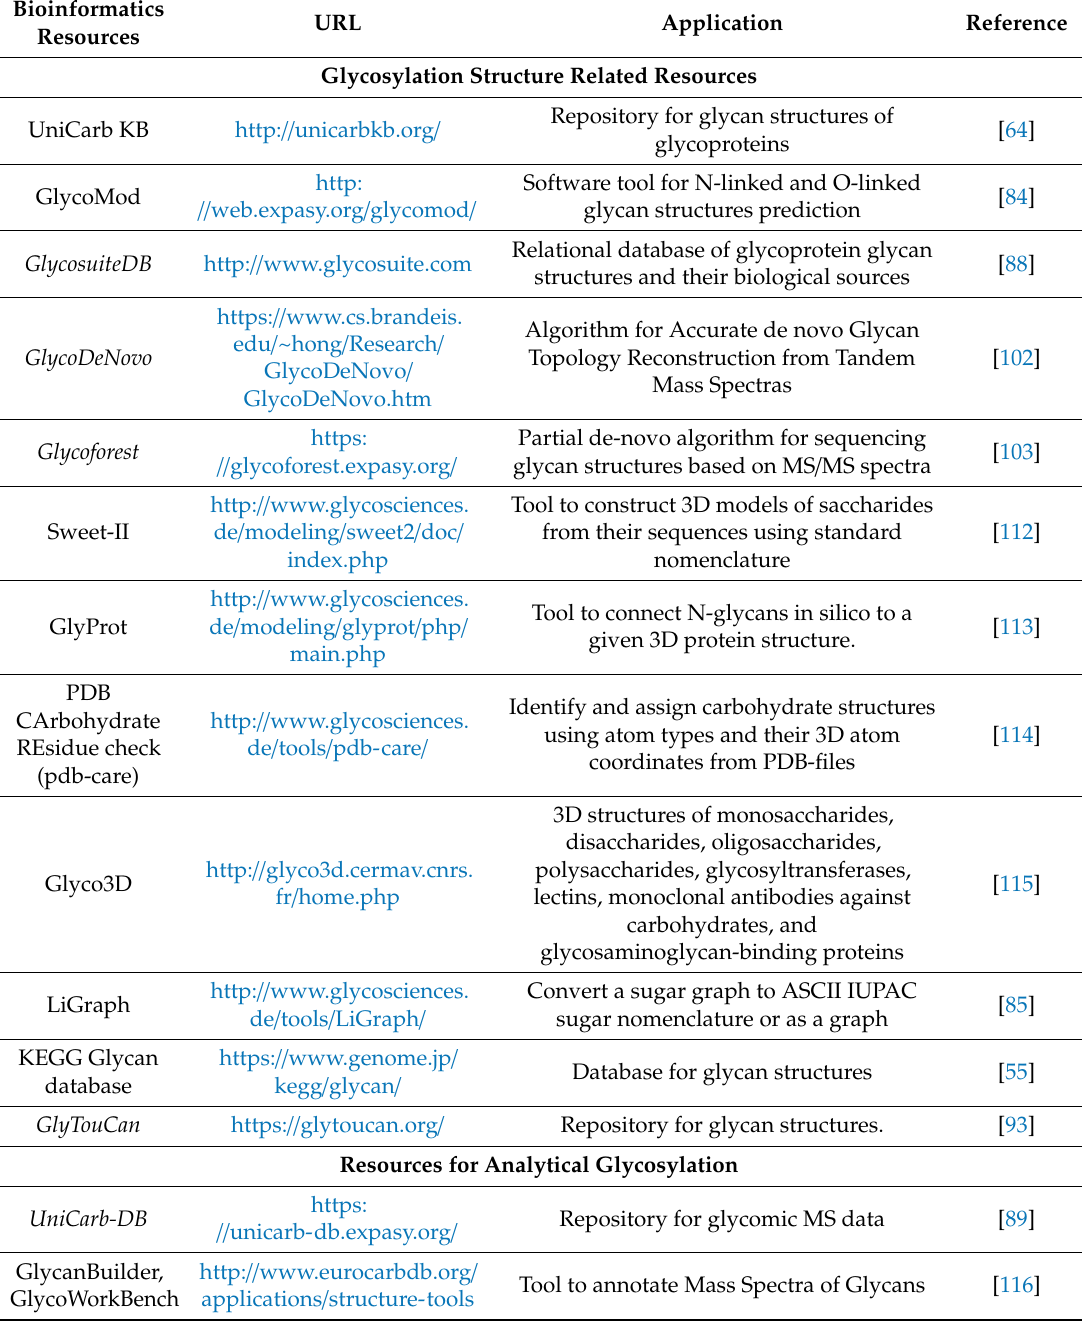
Table 1. Bioinformatic tool applications in various Glycosylation associated